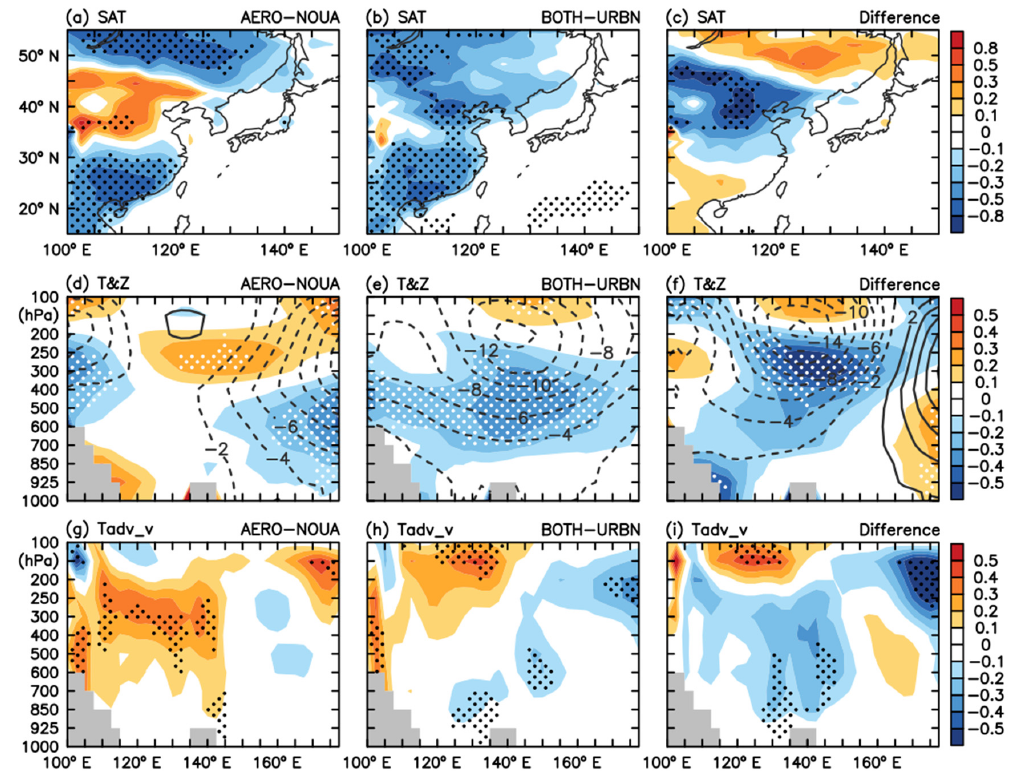
Figure 10. ( a – c ) The NDJ-mean AA-induced change in surface air temperature (SAT; in K) over East Asia from ( a ) AERO − NOUA; ( b ) BOTH − URBN; and ( c ) their difference (i.e., ( b ) minus ( a )). ( d – f ) and ( g – i ) Same as ( a – c ), respectively, but for vertical distributions of changes in ( d – f ) air temperature (T; color shading, in K) and geopotential height (Z; contours, at an interval of 2 gpm; dashed contours are for negative values and the zero contour is omitted for clarity) and ( g – i ) vertical temperature advection (Tadv_v; in K/day) along 35° N. The stippling indicates the change or difference in SAT, T, and Tadv_v is statistically significant at the 90% confidence level based on the MC test.